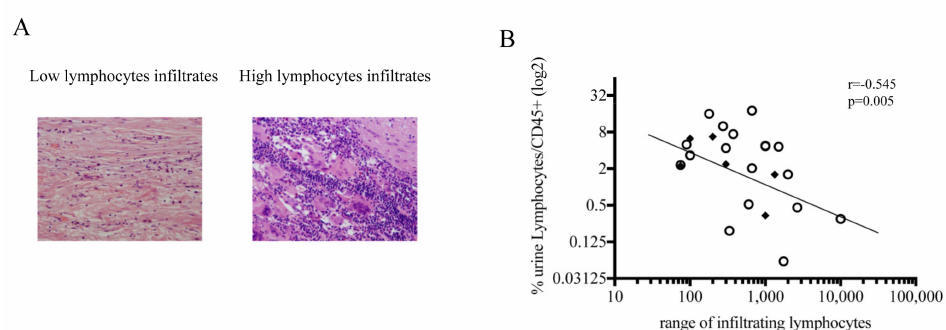
Figure 5. Relationship between urine lymphocytes at RC time and infiltrate lymphocytes present in the RC biopsy specimen. ( A ) Example of biopsies obtained at the time of RC from MIBC patients showing the lack infiltrating lymphocytes (20 × ), and ( B ) correlation between infiltrate lymphocytes in biopsies and the percentage of lymphocytes present in the urine of matched MIBC patients. Black diamonds correspond to patients who suffered recurrence. Spearman’s coefficient was used to correlate independent variables.